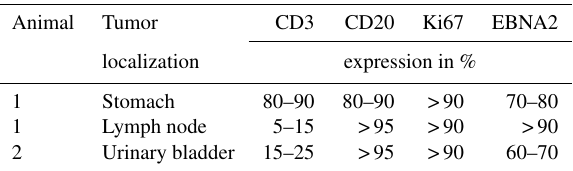
Table 2. Percentage of expression of different surface and intracel- lular markers in SIV-associated NHL based on immunohistochem-